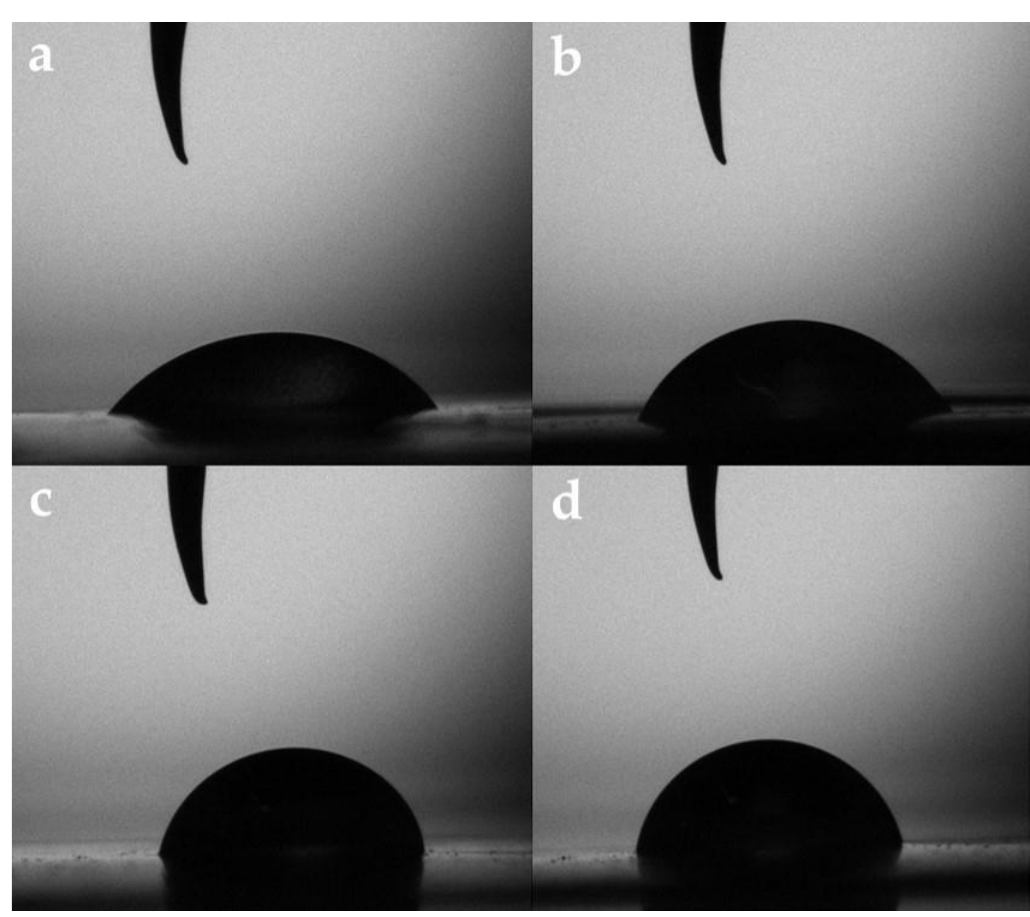
Figure 5. Water droplet images captured after 30 s of cassava starch films with quinoa starch nanocrystals at ( w / w ): ( a ) 0%; ( b ) 2.5%; ( c ) 5.0% and ( d ) 7.5%.